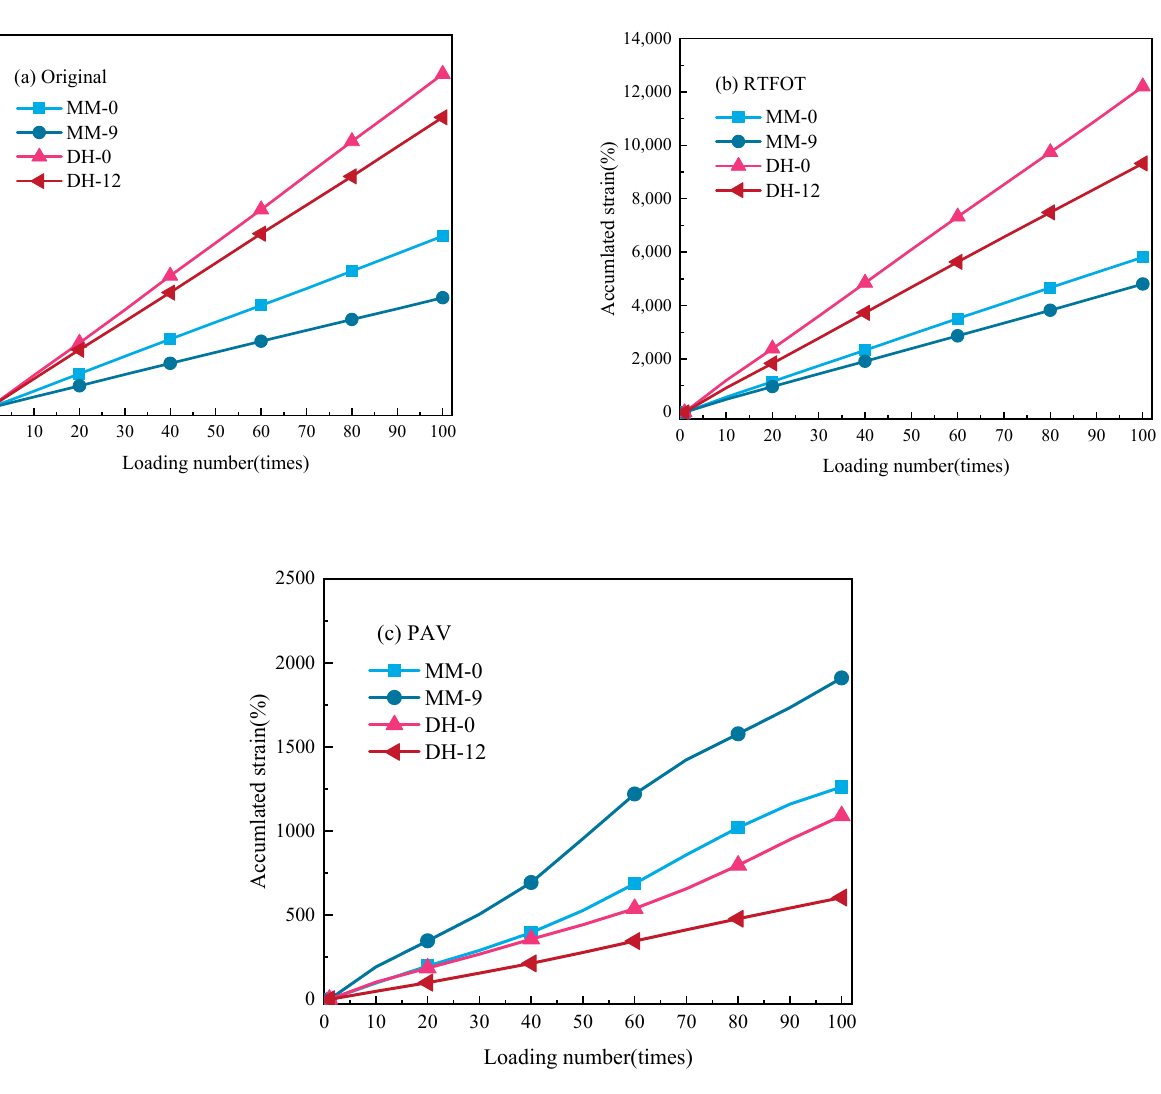
Figure 10. Relationship between cumulative strain and cycle loading times. ( a – c ) represents the cumulative strain of as is, short ‐ term aging and long ‐ term aging.